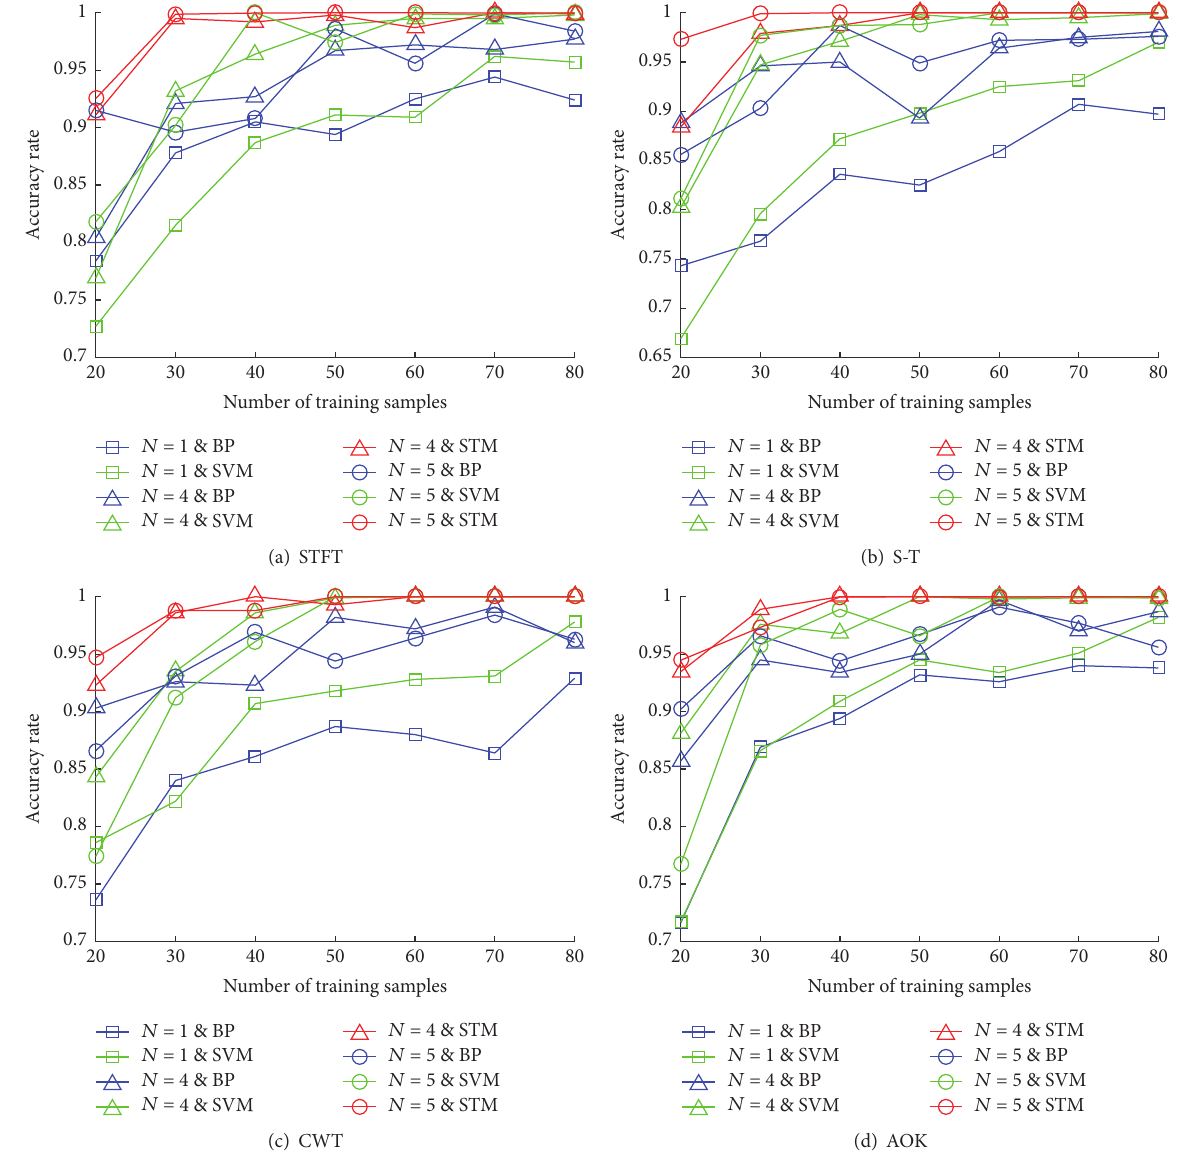
Figure 6: Comparison of recognition rate between hierarchical texture algorithms and traditional texture